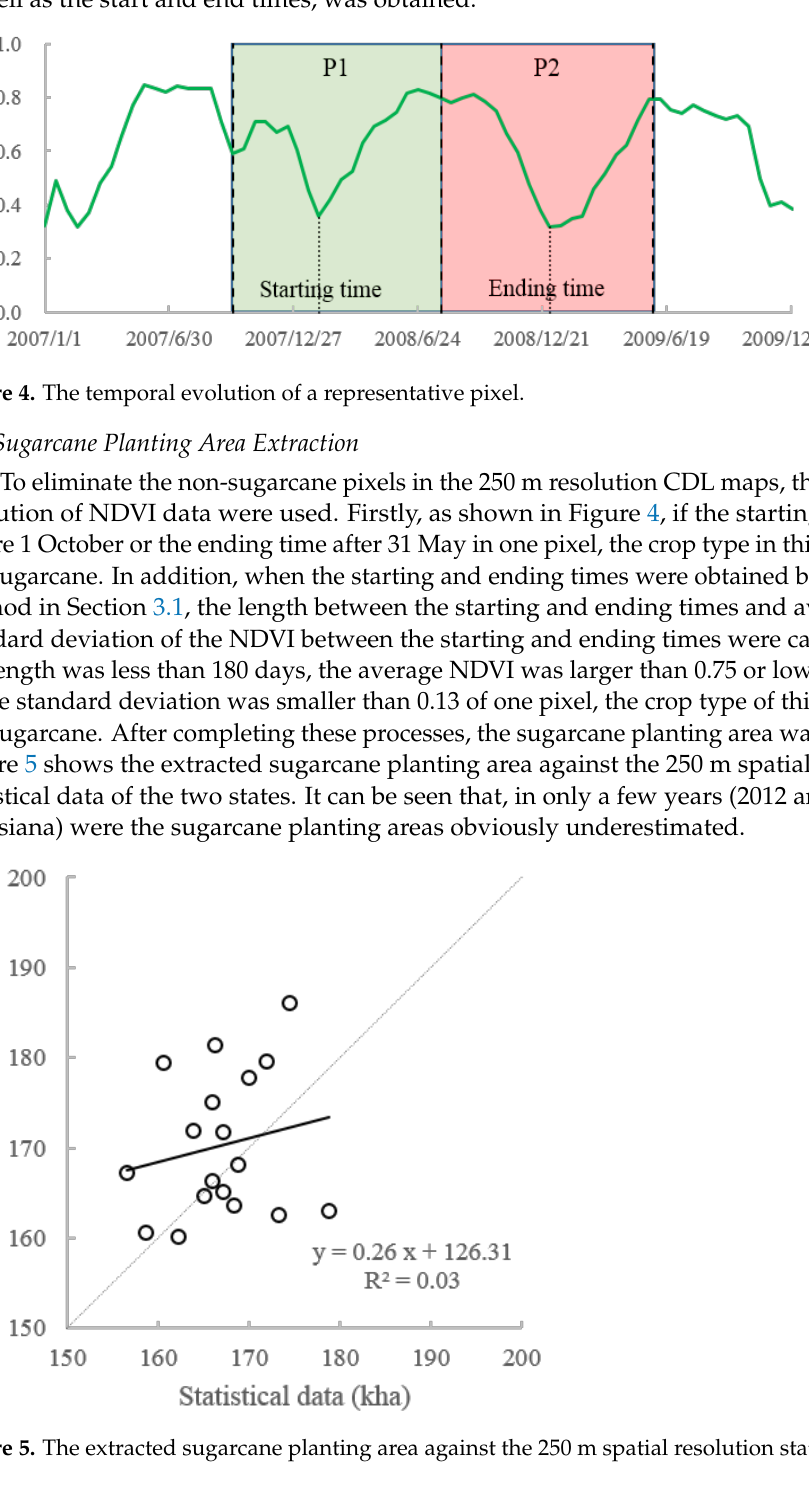
Figure 5. The extracted sugarcane planting area against the 250 m spatial resolution statistical data.